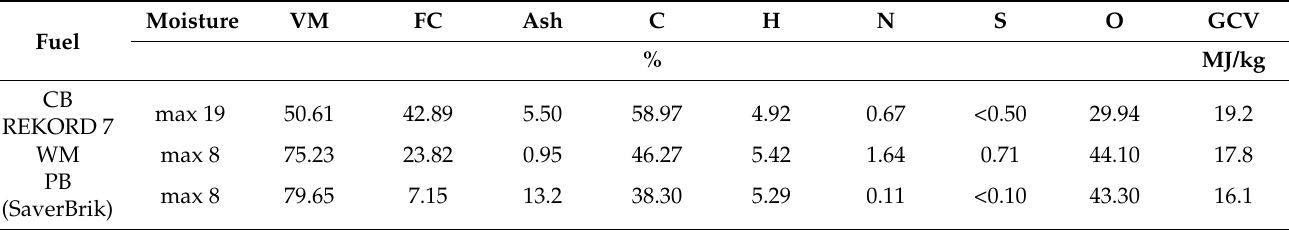
Table 1. Proximate and ultimate analysis of combusted fuels in dry